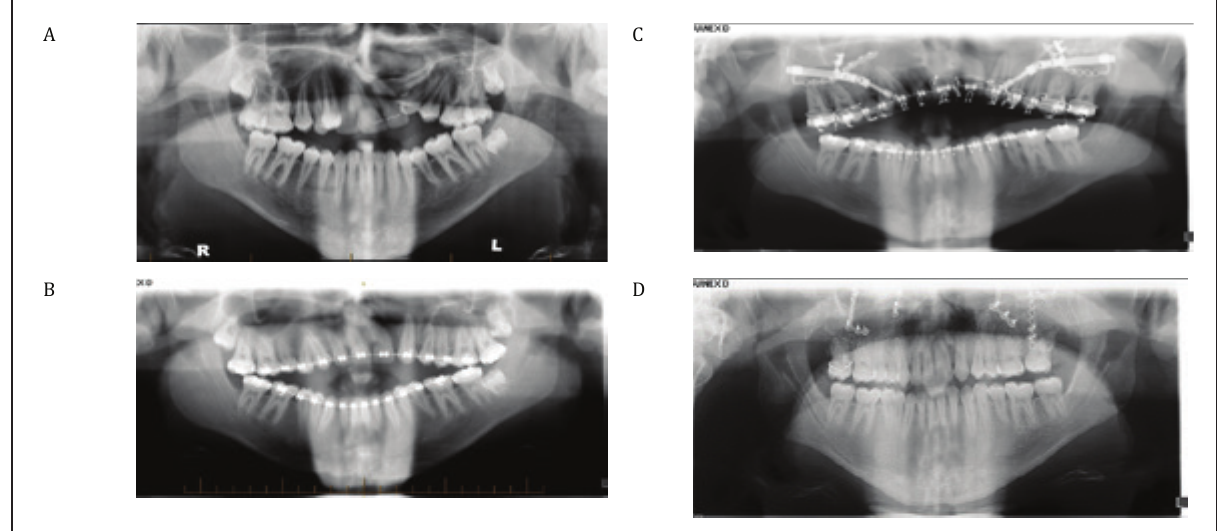
Figure 2. Panoramic radiographs (A) Pre-orthodontics (B) Pre-distractor placement (C) Pre-distractor activation with palatal acrylic splint in place (D) Orthodontic appliance